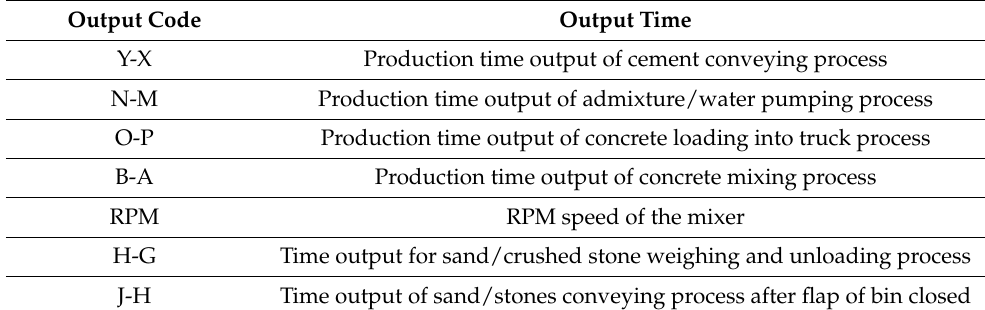
Table 6. Output Notations Used in Flow Chart of DT Functionality.